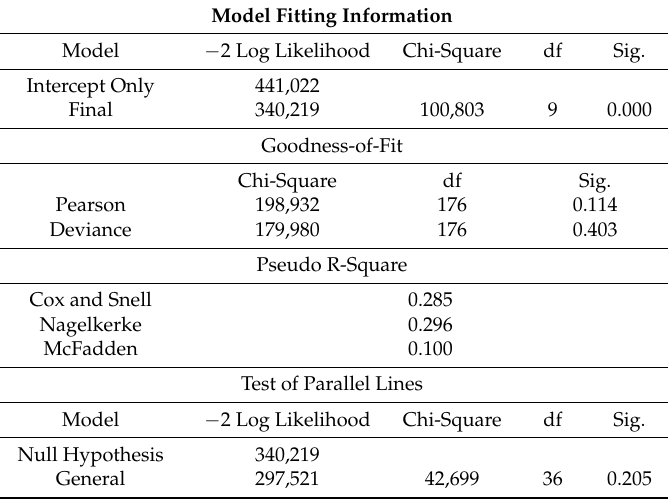
Table 5. Overall fitting indices for the public transport